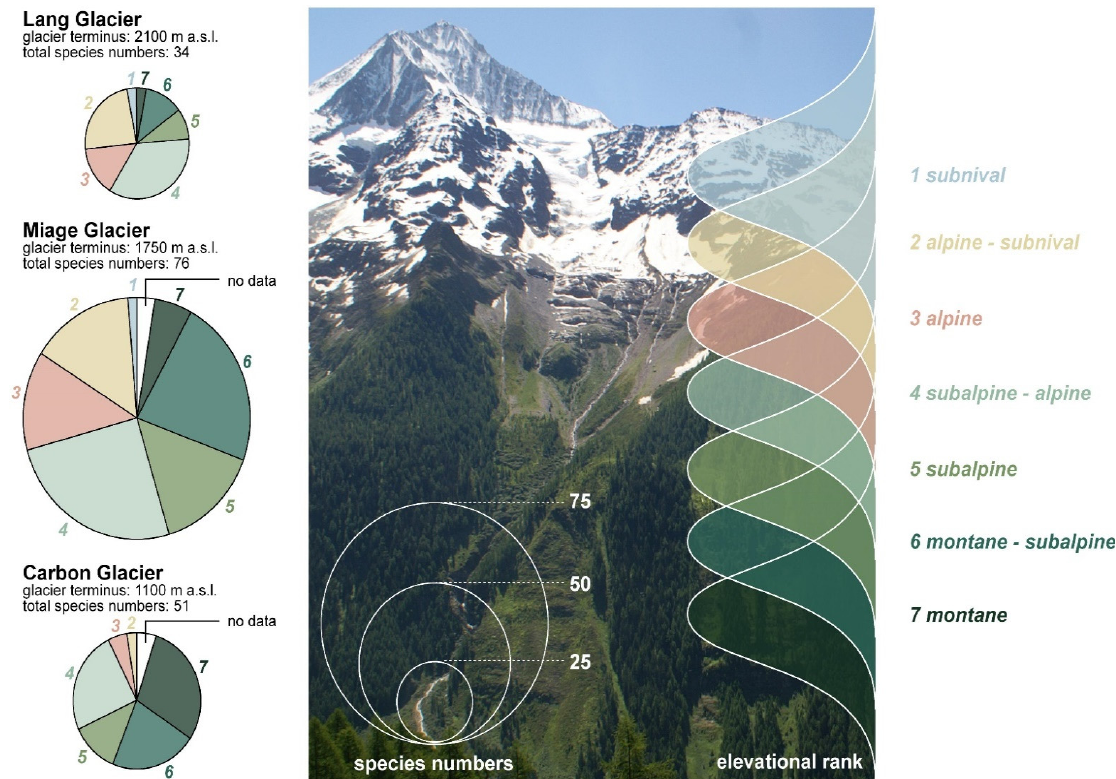
Figure 8. According to their primarily temperature-determined distribution along the elevational gradient, plant species refer to different elevational belts, here montane to subnival. The species distribution can be used as an ecological indicator for the respective temperature preferences, so for each plant species a particular elevational rank value can be assigned, here 1 (=subnival) to 7 (=montane) (according to information given in [101,102]). The pie charts on the left show the relative contribution of species from different provenances for the “montane” Carbon Glacier, the “subalpine” Miage Glacier and the “alpine” Lang